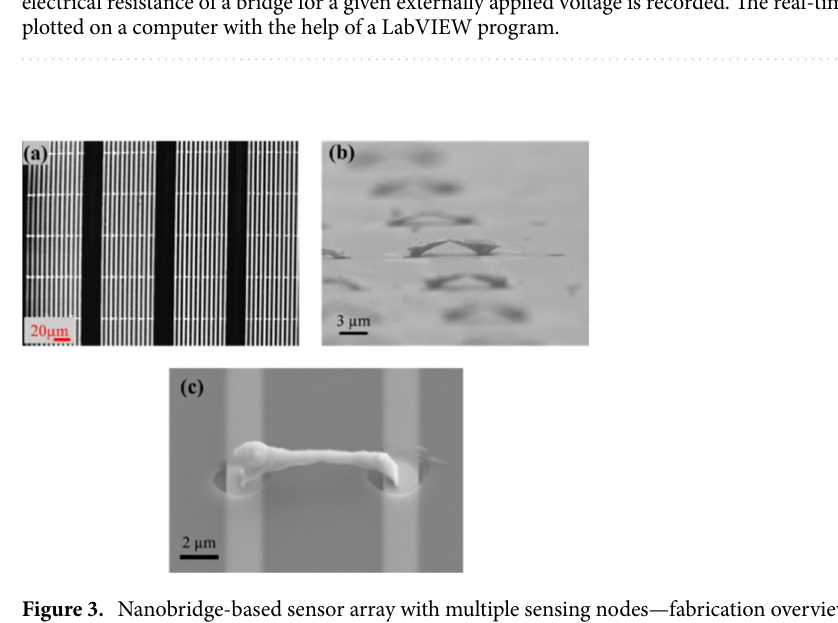
Figure 3. Nanobridge-based sensor array with multiple sensing nodes—fabrication overview. ( a ) A patterned photoresist with 2 µm openings is aligned to independent gold domain pairs. A negative bias of − 125 V is applied to the gold domains and 360 bridges are deposited in parallel. ( b ) While the openings are places in the x–y plane, the bridges grow out of the openings in the z-direction as shown in the SEM image with a 5-degree tilt. Such sensing nodes grown adjacent to each other cover the entire sensing area of the chip. ( c ) A single sensing bridge with its nanoparticulate sensing surface. All bridges are connected in parallel to the external circuit providing a bias voltage of 1.5